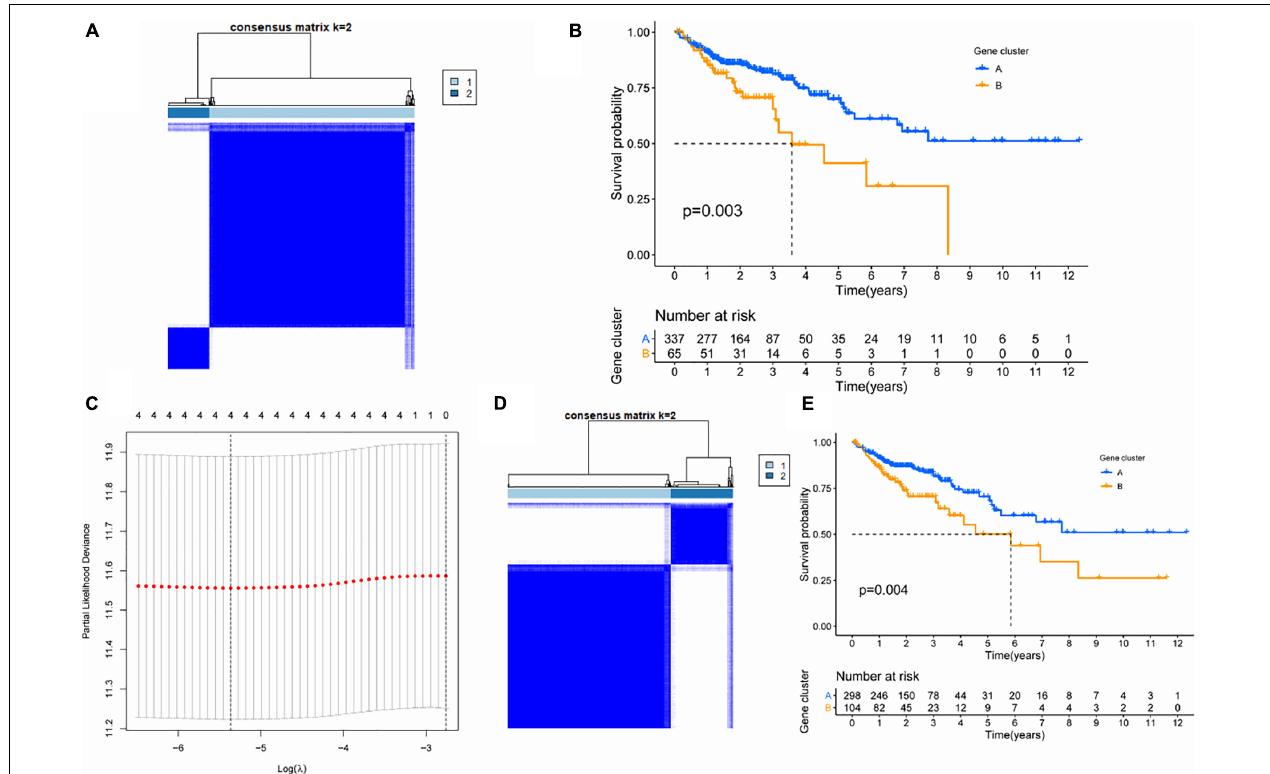
FIGURE 2 | Screening of key genes based on cluster analysis. (A) Consistency cluster analysis based on genes within the TAN module. (B) Survival analysis of patients between subgroups differentiated by genes within the TAN module. (C) Lasso analysis and screening of hub gene. (D) Consistency cluster analysis based on four hub genes. (E) Survival analysis of patients between subgroups differentiated by hub gene.